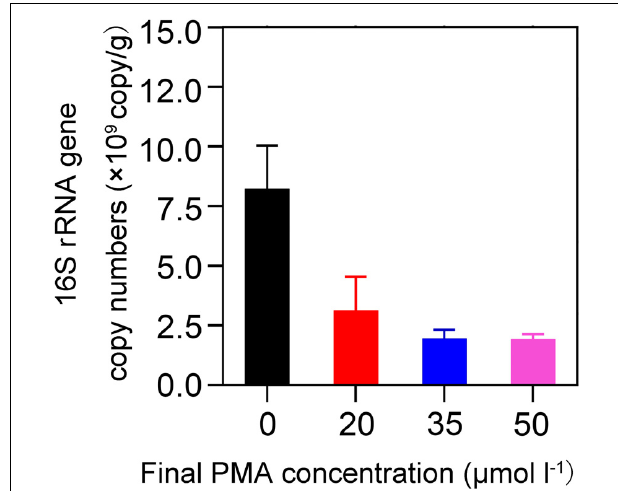
FIGURE 1 | Effect of PMA concentration on detecting the abundance of 16S rRNA gene by qPCR. The quantities 0, 10, 17.5, and 25 µ L of 2 mM PMA were added to 1 mL of 1% PM sample suspension, respectively, to obtain different PMA concentrations of 0, 20, 35, and 50 µ M.